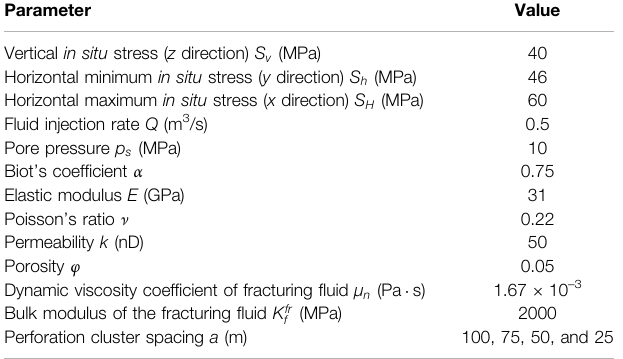
TABLE 1 | Basic physical parameters of the model. Parameter Value